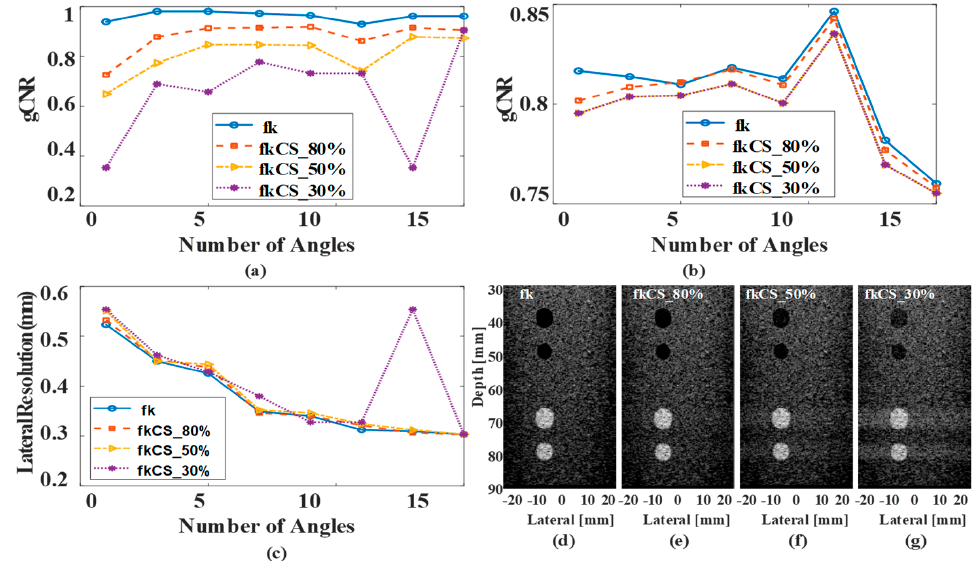
Figure 10. Influence of number of angles on fkCS. ( a ) gCNR of cyst, ( b ) gCNR of strong reflection area, ( c ) lateral resolution with different number of angles and compression rate, ( d–g ) are B mode images based on beamformer of Stolt’s f-k, and fkCS with compression of 80%, 50% and 30% with 40 dB dynamic range, respectively.